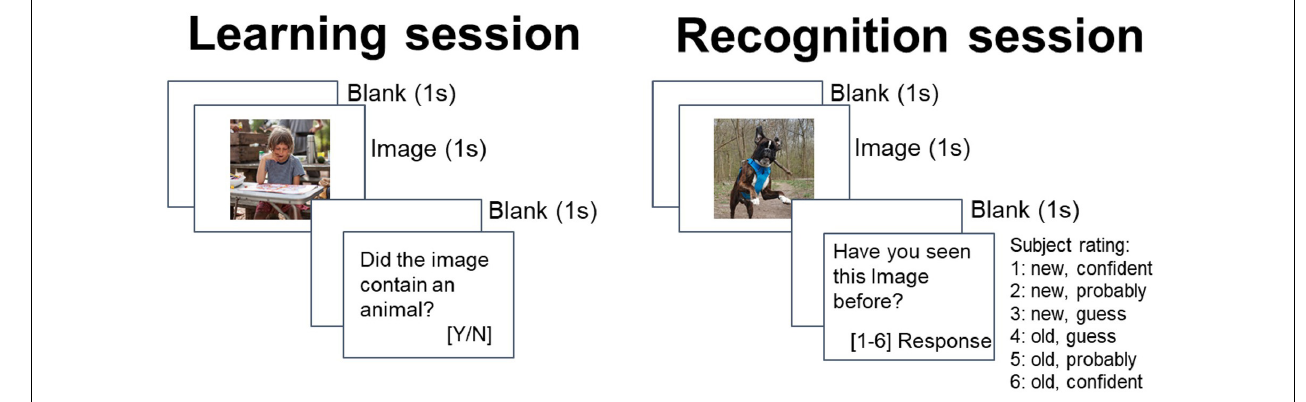
FIGURE 1 | Trial structure at learning and